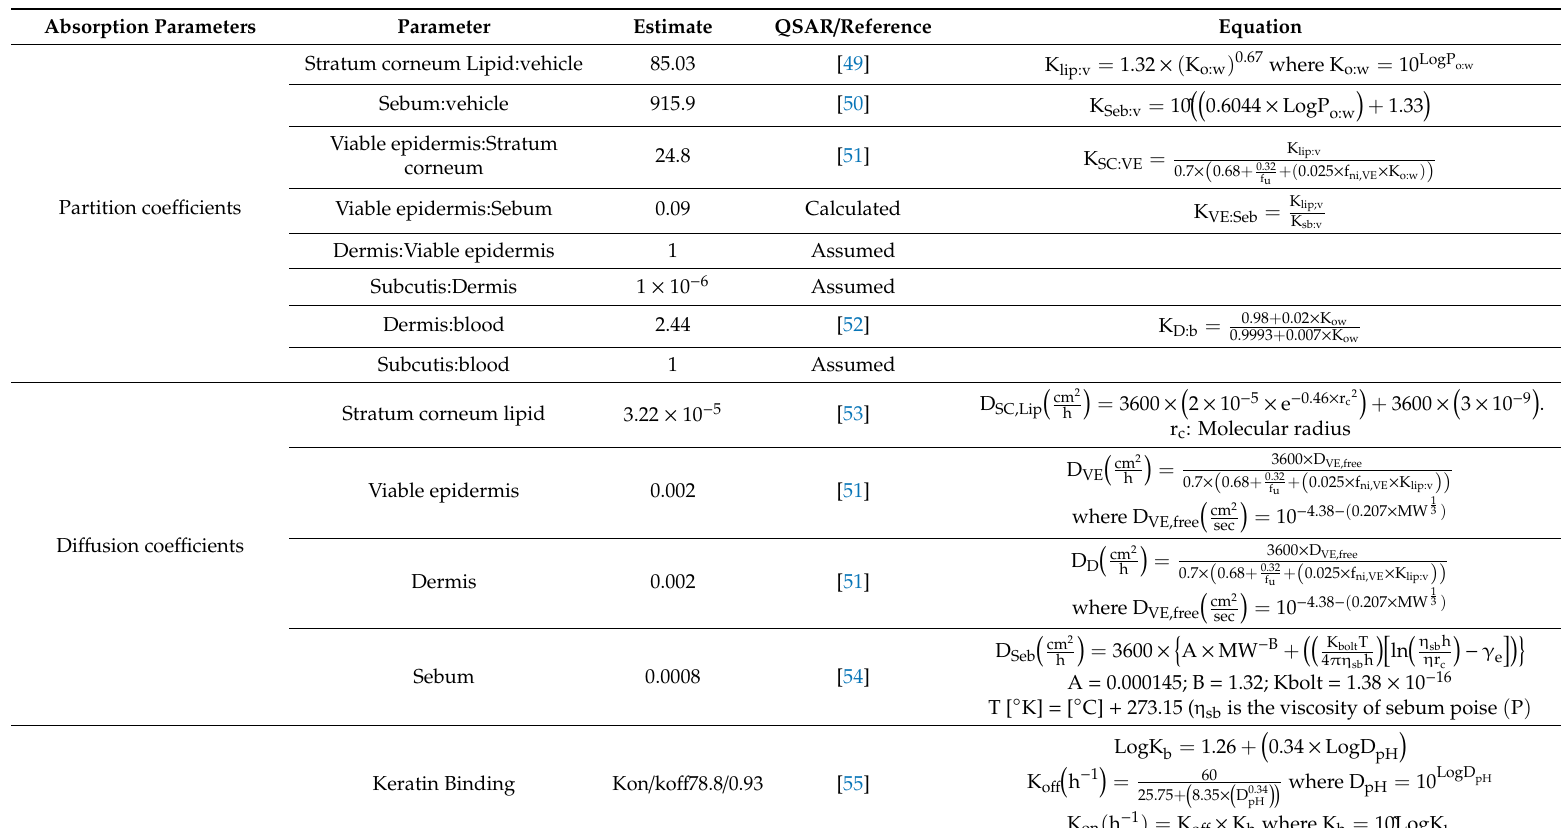
Table 2. Absorption